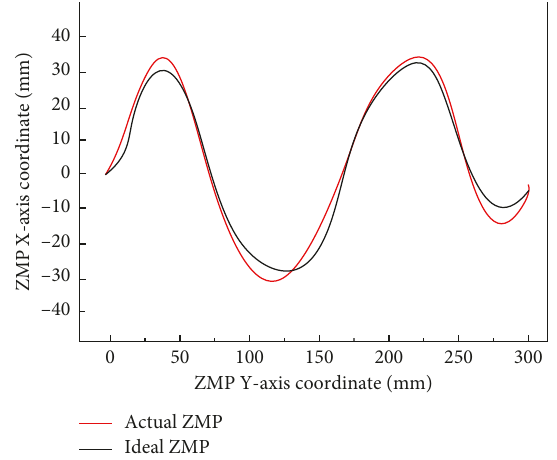
Figure 7: Ideal ZMP trajectory vs. Actual ZMP trajectory